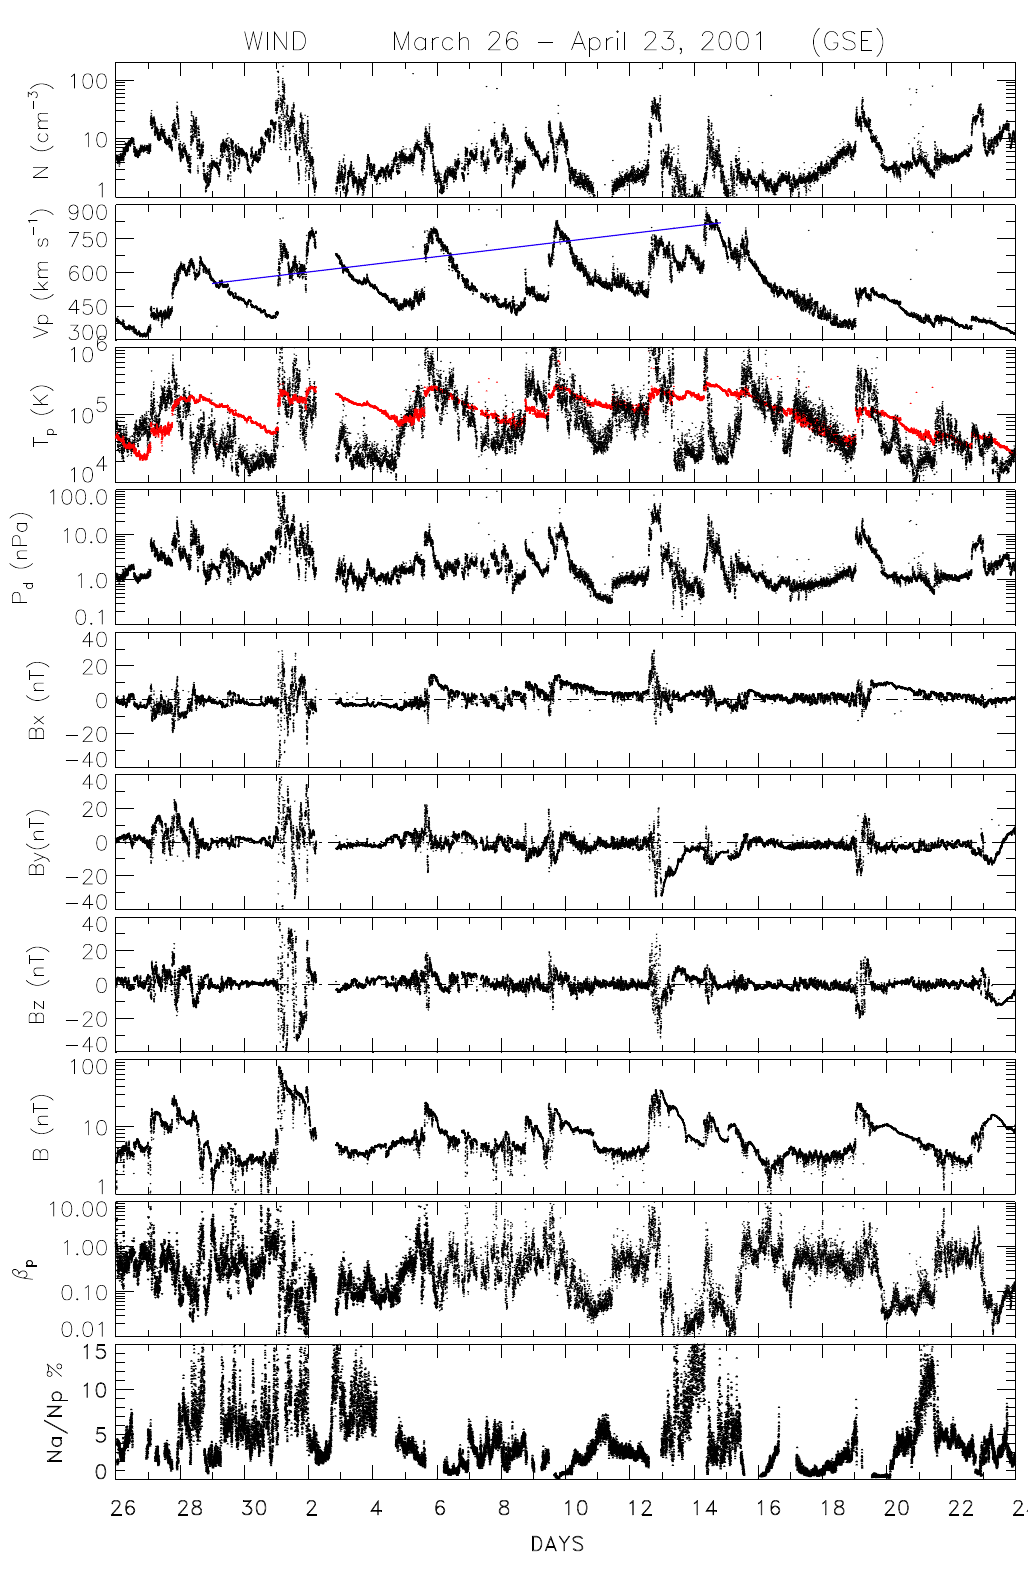
Fig. 6. Plasma and magnetic field data from the Wind spacecraft for the time interval 26 March–24 April 2001. From top to bottom are plotted the proton number density, bulk speed, temperature and dynamic pressure, the components of the magnetic field in GSE coordinates, the field strength, the proton plasma beta and the α -particle to proton number density ratio in